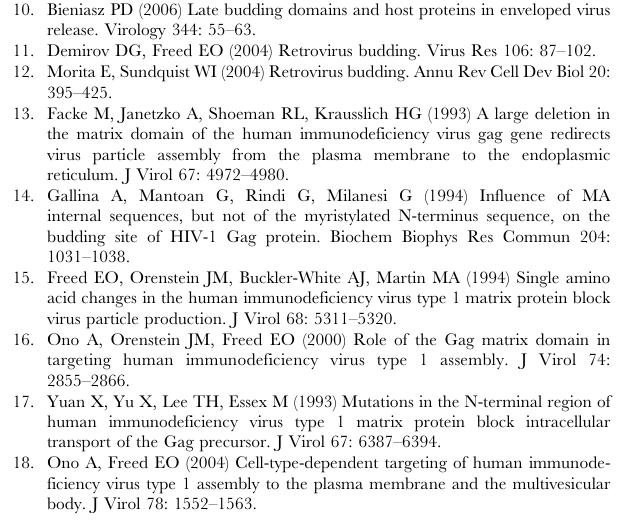
were labeled for 5 min with ReAsH (Gag) for 5 min at 37 u C, washed, fixed in 3.7% formaldehyde and then stained with anti- CD63 Ab (CD63). Lower panels show the overlay between the Gag and CD63 staining. Scale bars = 15 m m. Figure S2 Quantification of Gag/CD63 and Gag/CD81 Colocalization. MDMs infected with VSV-G-pseudotyped were analyzed for Gag, CD63 and CD81 localization as described in the Fig. 3 legend. Pearson coefficient (R) values were obtained for a total of 75 cells and were plotted on a scale of 0 to 1 (x-axis). The y-axis indicates the number of cells scored within each R-value range. Figure S3 Sample Images Used to Quantify the Localization of Gag at the Synapse. Illustrates method used for data presented in Fig. 6C (panel A) and Fig. 7C (panel B). The microscopy images were opened in ImageJ and a plot profile was obtained. A column average plot was generated, in which the x-axis represents the horizontal distance through the image and the y-axis the vertically averaged pixel intensity. The % Gag at the synapse was calculated as: (pixel intensity of Gag signal at synapse)/(total intensity of Gag in the cell + synapse) 6 100. N values indicate the number of cells analyzed in each data set. Scale bar = 10 m m. Found at: doi:10.1371/journal.ppat.1000015.s003 (3.67 MB TIF) Video S1 Analysis of 29KE/31KE-TC Gag localization in MDM in 3D. The z-series reconstructions were obtained by using the Maximum Intensity Projection mode from the image processing software OsiriX. The data correspond to the MDM 29KE/31KE-TC Gag panel in Fig. 2. Found at: doi:10.1371/journal.ppat.1000015.s004 (0.18 MB MOV) Video S2 Analysis of Gag localization in 3D. The z-series reconstructions were obtained by using the Maximum Intensity Projection mode from the image processing software OsiriX. The image in this figure corresponds to Fig. 5A. Found at: doi:10.1371/journal.ppat.1000015.s005 (0.41 MB MOV) Video S3 Analysis of Gag localization in 3D. The z-series reconstructions were obtained by using the Maximum Intensity